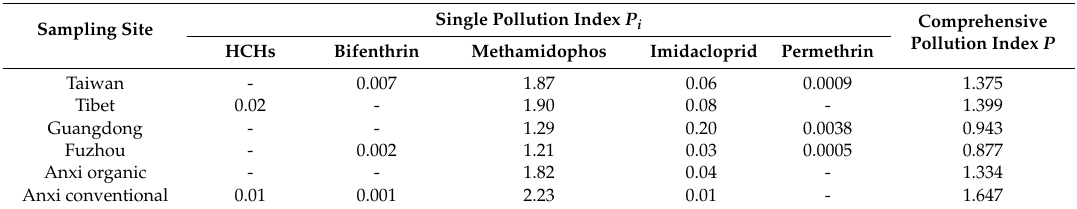
Table 5. Pesticide residue pollution indices for each soil pesticide residue in the soil samples of tea plantations in